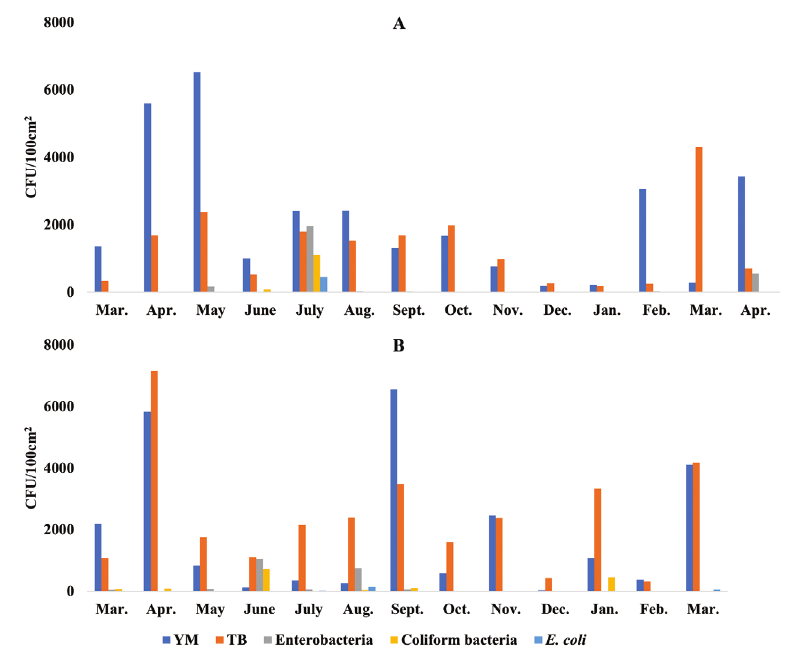
Figure 2. Distribution of culturable bacterial and fungal abundances on touched stalagmites from 2015 to 2016 in Ursilor ( A ) and Muierilor ( B ). TB, total aerobic bacteria; YM, yeasts and moulds; E. coli , Escherichia coli